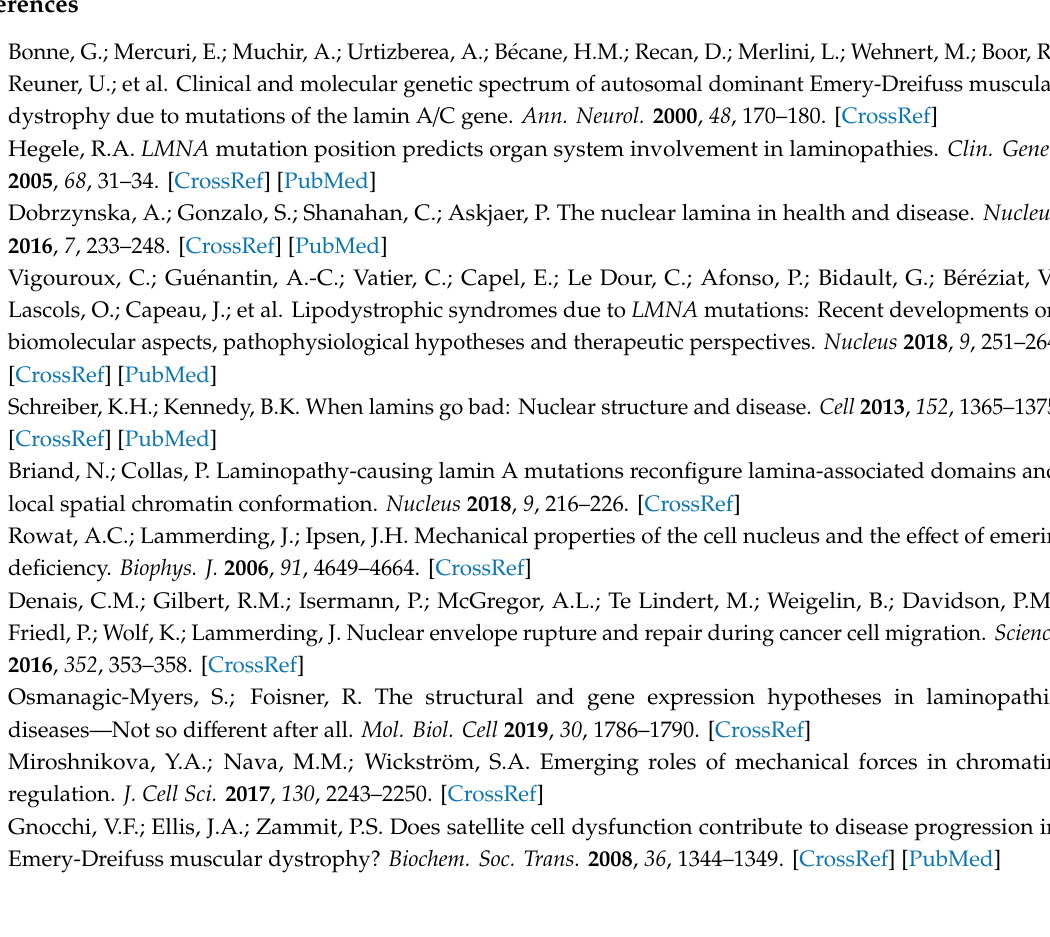
Figure S1. Principal component analysis (PCA) plots of 24 samples; Figure S2. Heat map of normalized read counts for 24 samples and 14,321 genes; Figure S3. Relative mtDNA content in C2C12 transgene lines analyzed by real-time PCR amplification. Figure S4. Glycolytic capacity of myotubes; Figure S5: The fraction of h LMNA -positive cells in di ff erentiated cultures. Table S1. Primers used for mtDNA quantification; Table S2. Full list of di ff erential-expressed genes. Table S3. Full list of pathways that were significantly di ff erent between transgene lines; Table S4. Sequences of